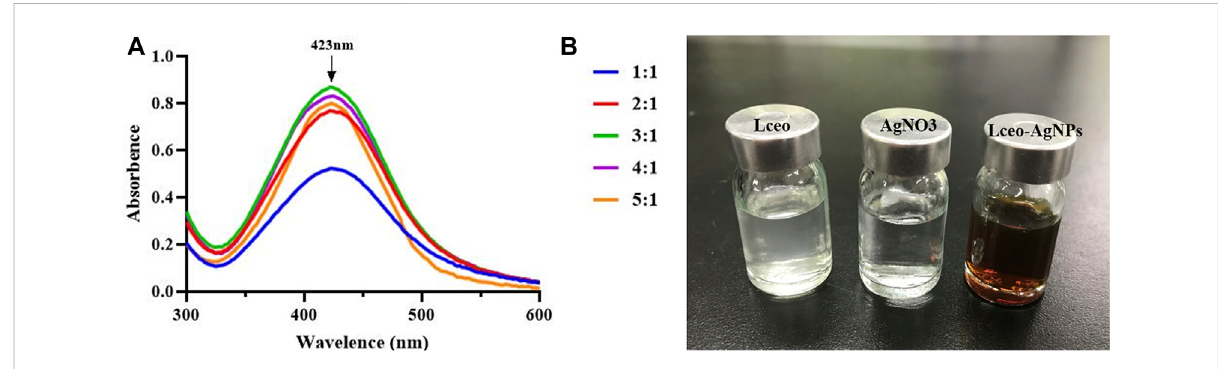
FIGURE 1 UV-vis wavelength spectra of Lceo-AgNPs with different ratio of Lceo: AgNO 3 in the range of 300 – 600 nm (A) and the colors of Lceo, AgNO 3 , and Lceo-AgNPs (B)